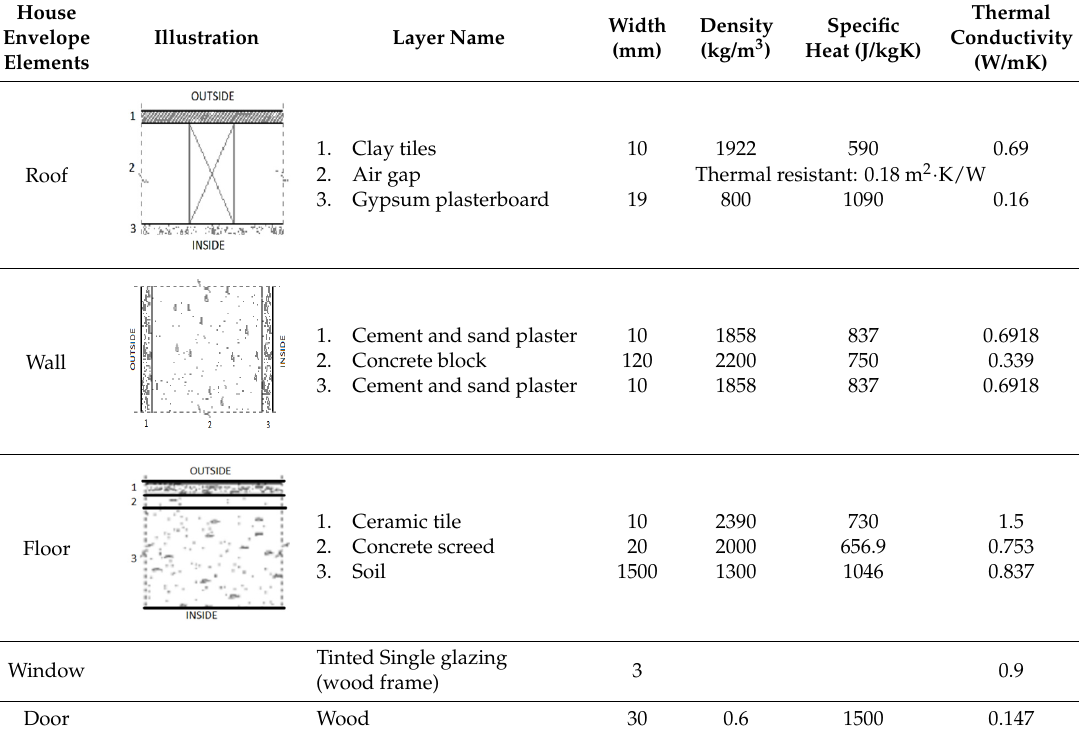
Figure 7. Typical house in Indonesia. Table 16. House envelopes material and thermal properties of each layer.